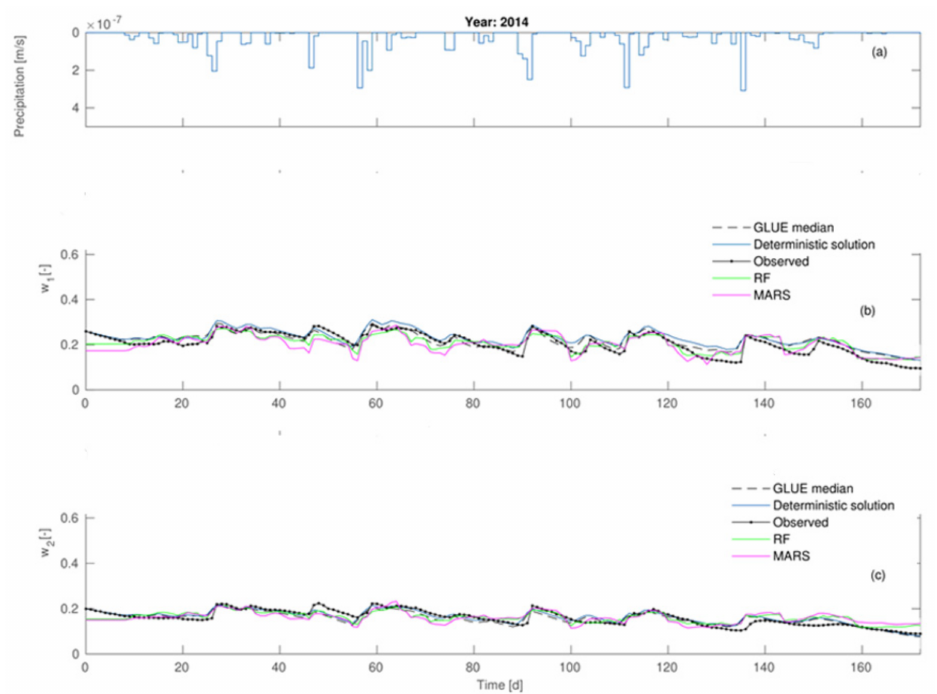
Figure 6. Comparison of the modeled and observed soil moisture contents by Deardorff model for the second calibration stage: ( a ) precipitation rates ( b ) w 1 -soil moisture content of the first layer ( c ) w 2 -soil moisture content of the second